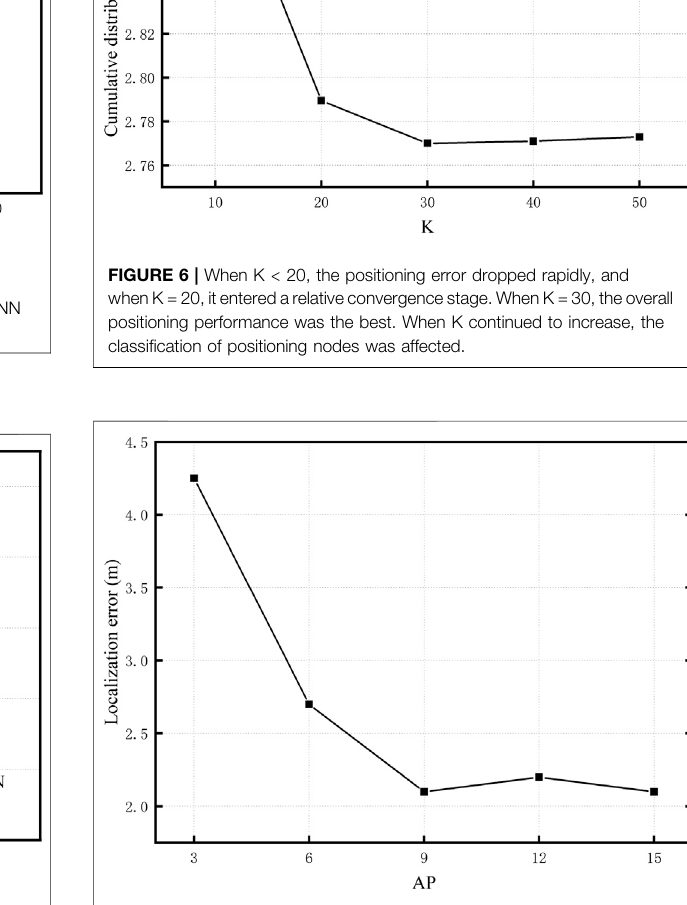
FIGURE 7 | The relationship between frequency AP and error. When AP (cid:1) 9, the positioning performance was the best, which was similar to AP (cid:1) 15. When AP (cid:1) 12, positioning error slightly increased because of accidental factors.